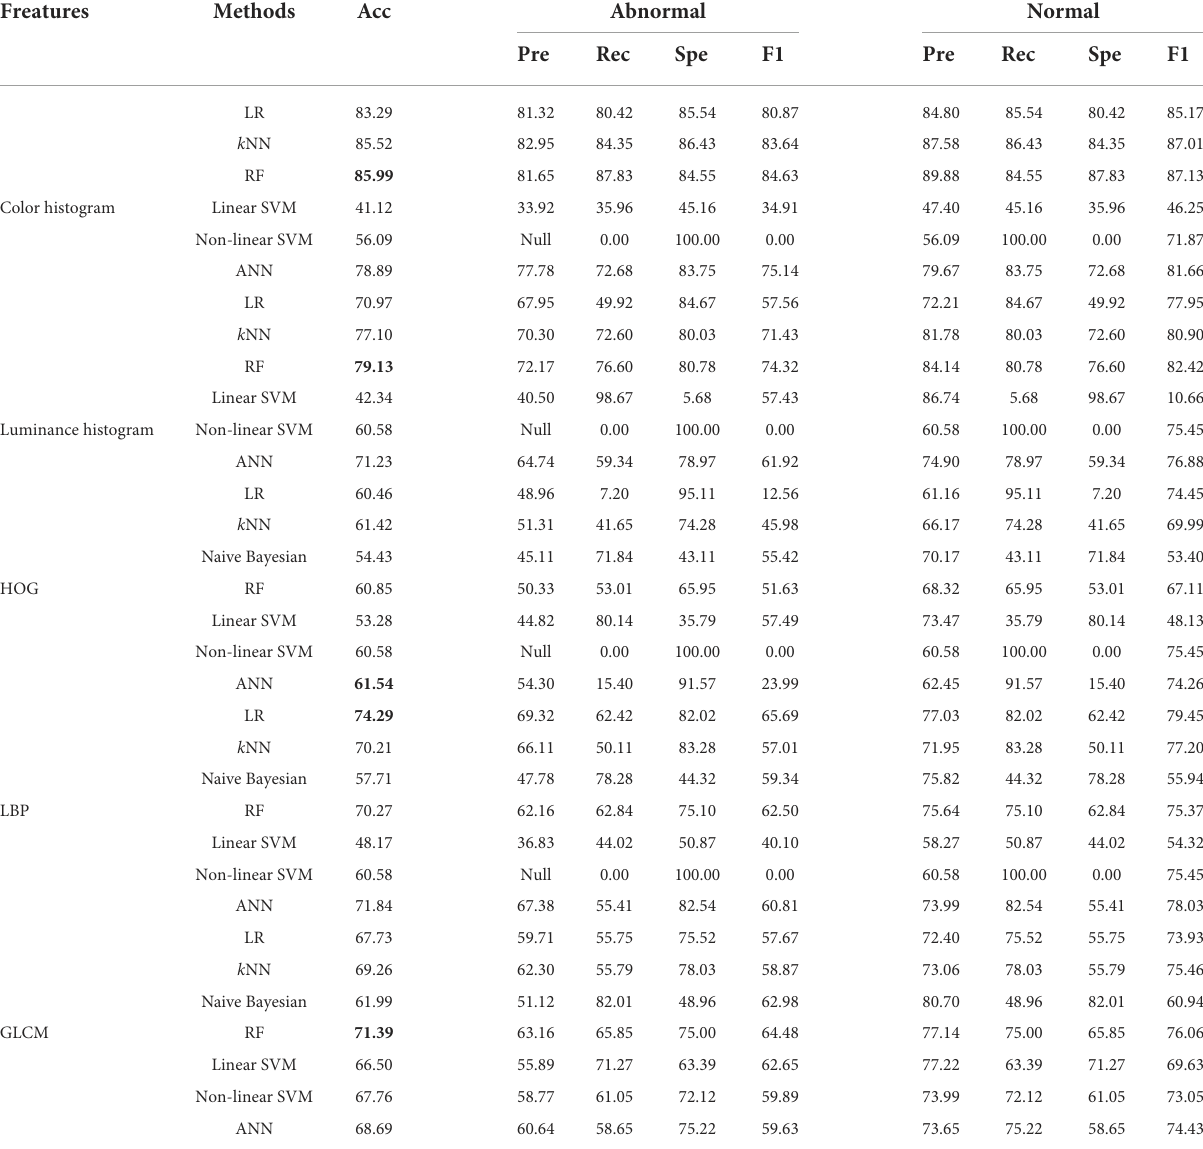
TABLE 3 Classification results of five image features using different classifiers in the 160 × 160 pixels sub-database of GasHisSDB [In (%)]. Freatures